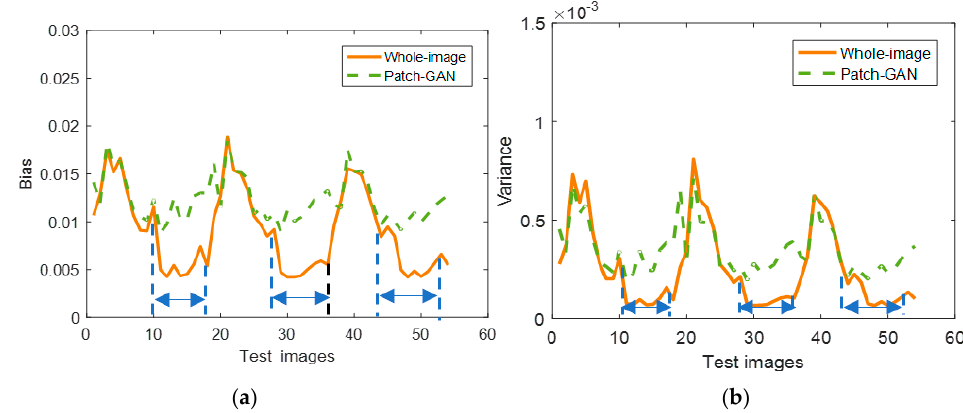
Figure 5. Reconstruction results comparison of whole-image discriminator and Patch-GAN: ( a ) bias; ( b ) variance. The bias and variance of whole-image strategy are much lower than Patch-GAN of the later frames, as shown between the dashed blue line.